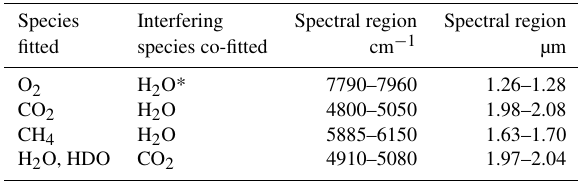
Table 1. Details of spectral windows used for